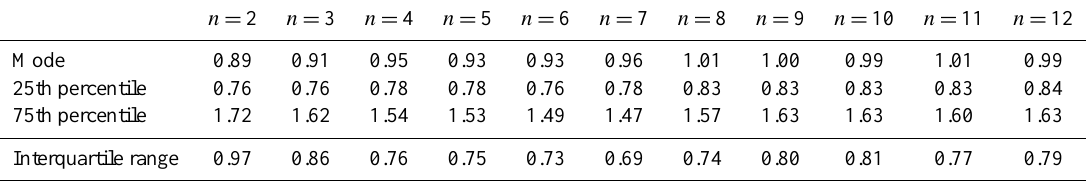
Table 1. Mode, 25th and 75th percentiles and interquartile range calculated from the logarithmic normal distribution functions fitted to the results for C − 1 for 2 ≤ n ≤ 12 (rounded values). Calibration was performed using synthetic data with realistic precipitation 3